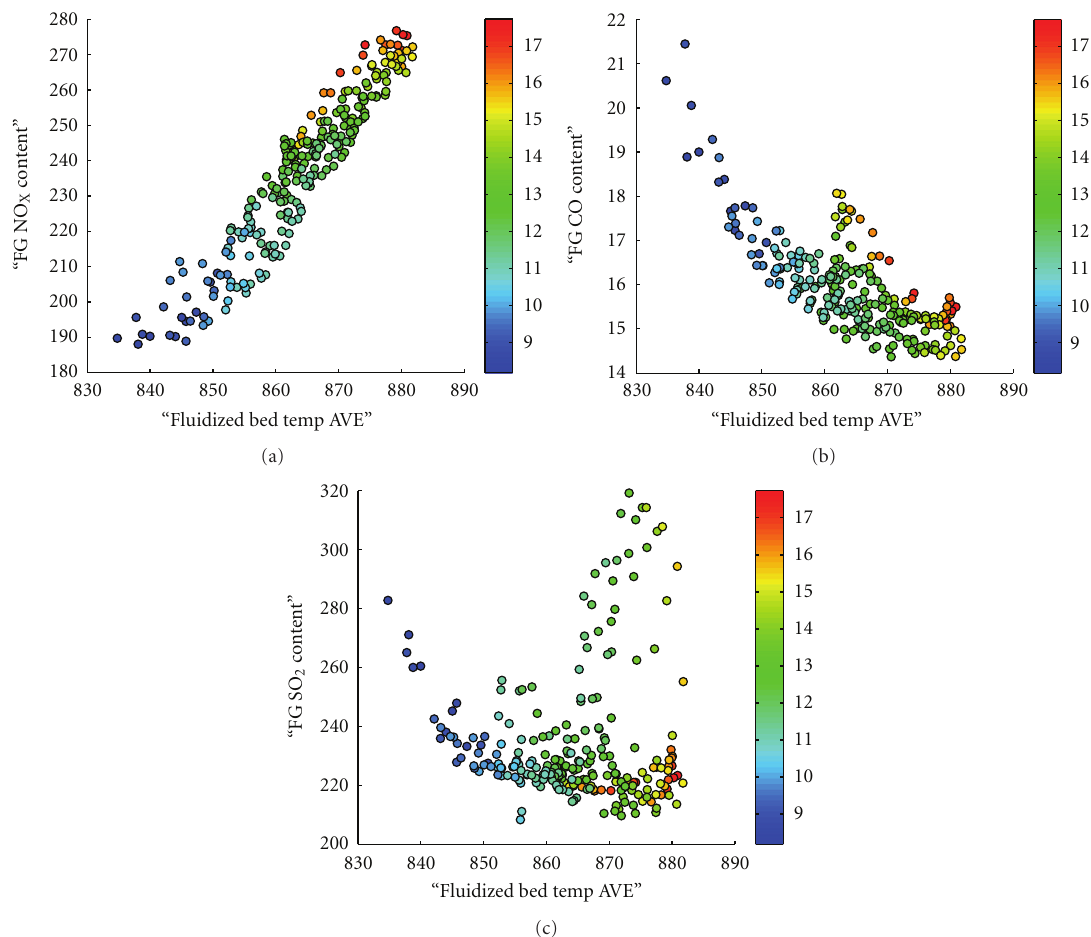
Figure 6: Emission models of the process state of high-steam flow. (a) NO x , (b) CO, and (c) SO 2 content [mg/Nm 3 ] of flue gas (FG) as a function of the bed temperature [ ◦ C] by using the reference vectors of SOM neurons. Color scale indicates the deviation of the bed temperature [ ◦ C].